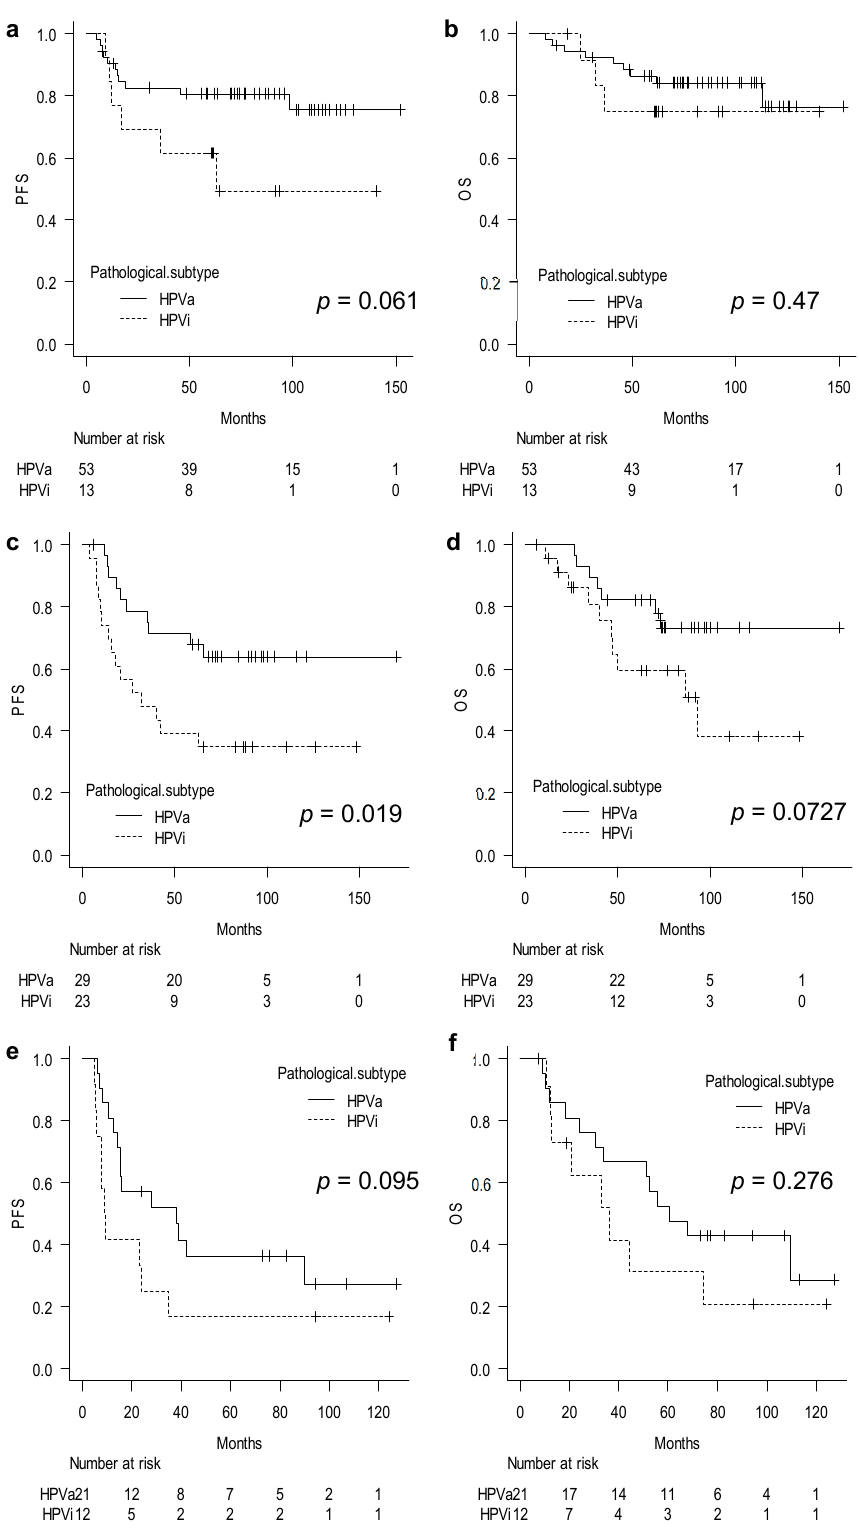
Figure 2. Sub-group analysis stratified by FIGO stage: ( a ) Progression-free survival in stages IB3–IIA; ( b ) overall survival in stages IB3–IIA; ( c ) progression-free survival in stage IIB; ( d ) overall survival in stage IIB; ( e ) progression-free survival in stage IIIC1; and ( f ) overall survival in stage IIIC1. FIGO, International Federation of Gynecology and Obstetrics; HPVa, human papilloma virus-associated; HPVi, human papilloma virus-independent; OS, overall survival; PFS, progression-free